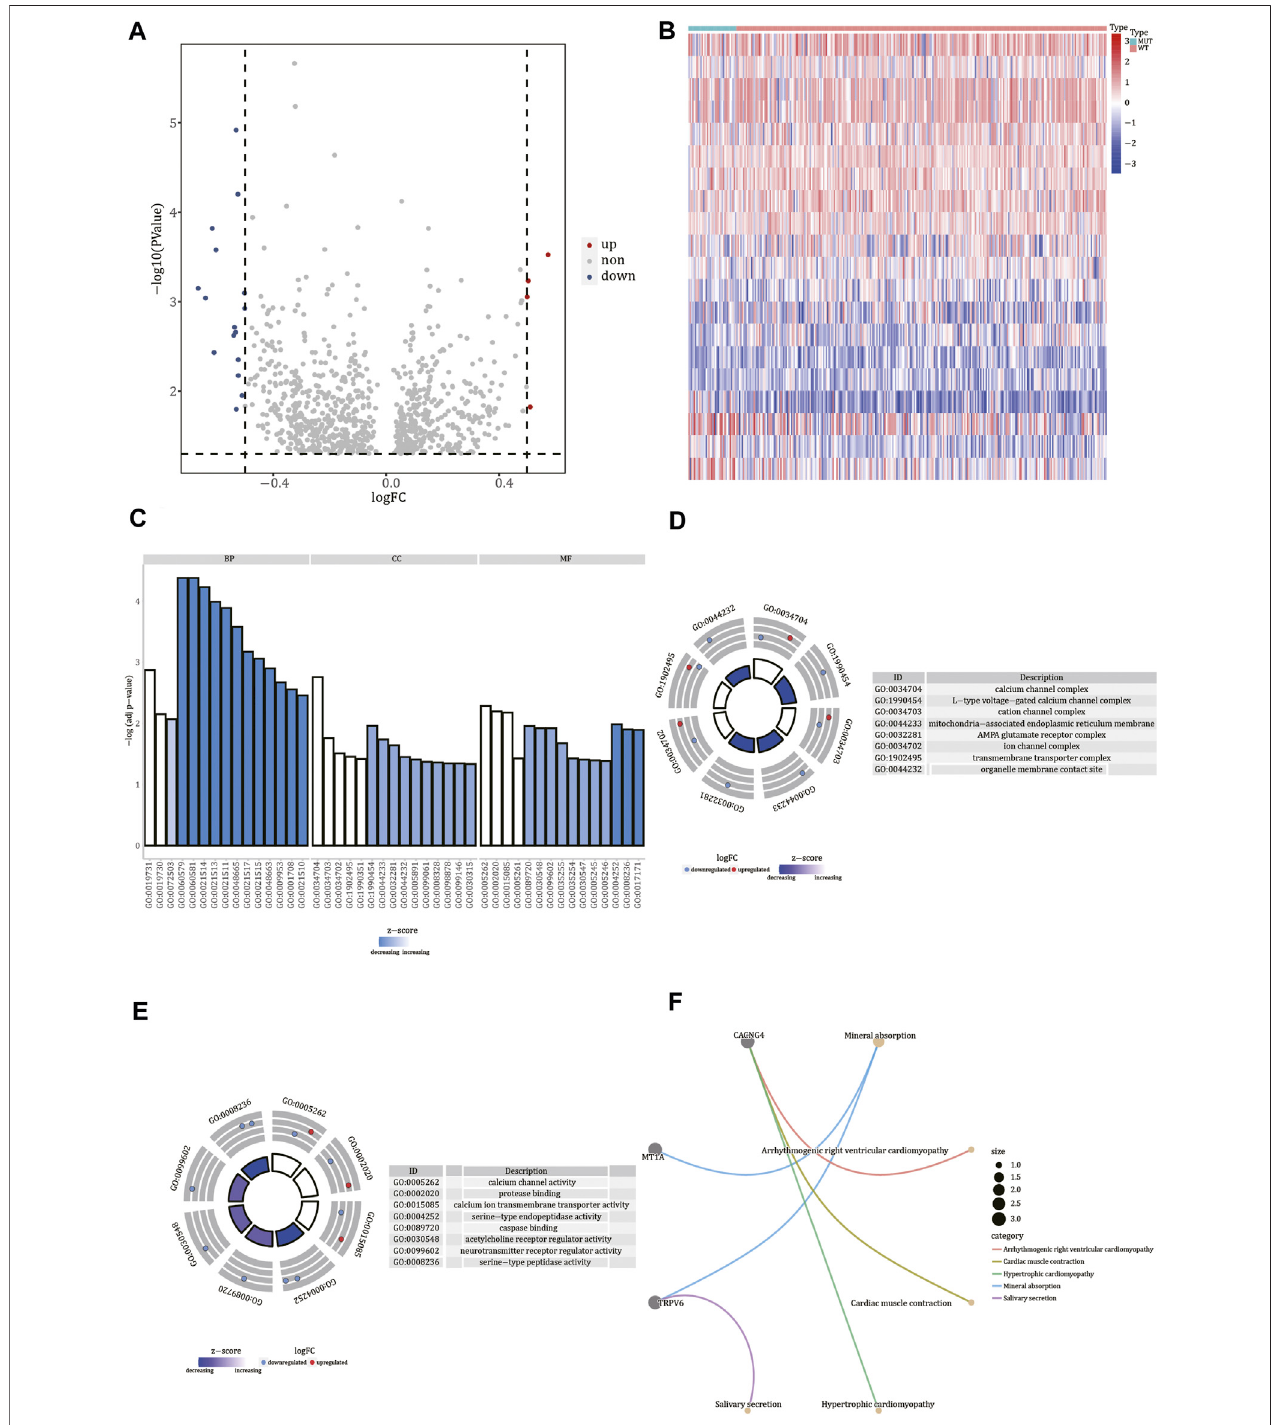
FIGURE 6 | Functional enrichment analysis of differentially expressed genes. (A) Volcano plot of differentially expressed genes. The red nodes indicate up- regulation, blue nodes indicate down-regulation, and gray nodes indicate non-signi fi cant expression changes. (B) Heat map of differentially expressed genes. Red represents high gene expression levels, blue represents low gene expression levels, green annotation bars indicate FREM2- mutant samples, and red annotation bars indicate FREM2 -wild type samples. The result of Gene Ontology functional enrichment analysis of differentially expressed genes (C) , and the results of molecular function (D) and cellcompartment (E) terms enrichment analysisaredisplayed. Blueindicates down-regulation ofexpression,red indicates up-regulation ofexpression, the middle quadrilateral indicates the effect of the gene on the enriched Gene Ontology terms, light color indicates inhibition, and dark color indicates activation. (F) The top fi ve pathways of Kyoto Encyclopedia of Genes and Genomes enrichment analysis of differentially expressed genes.